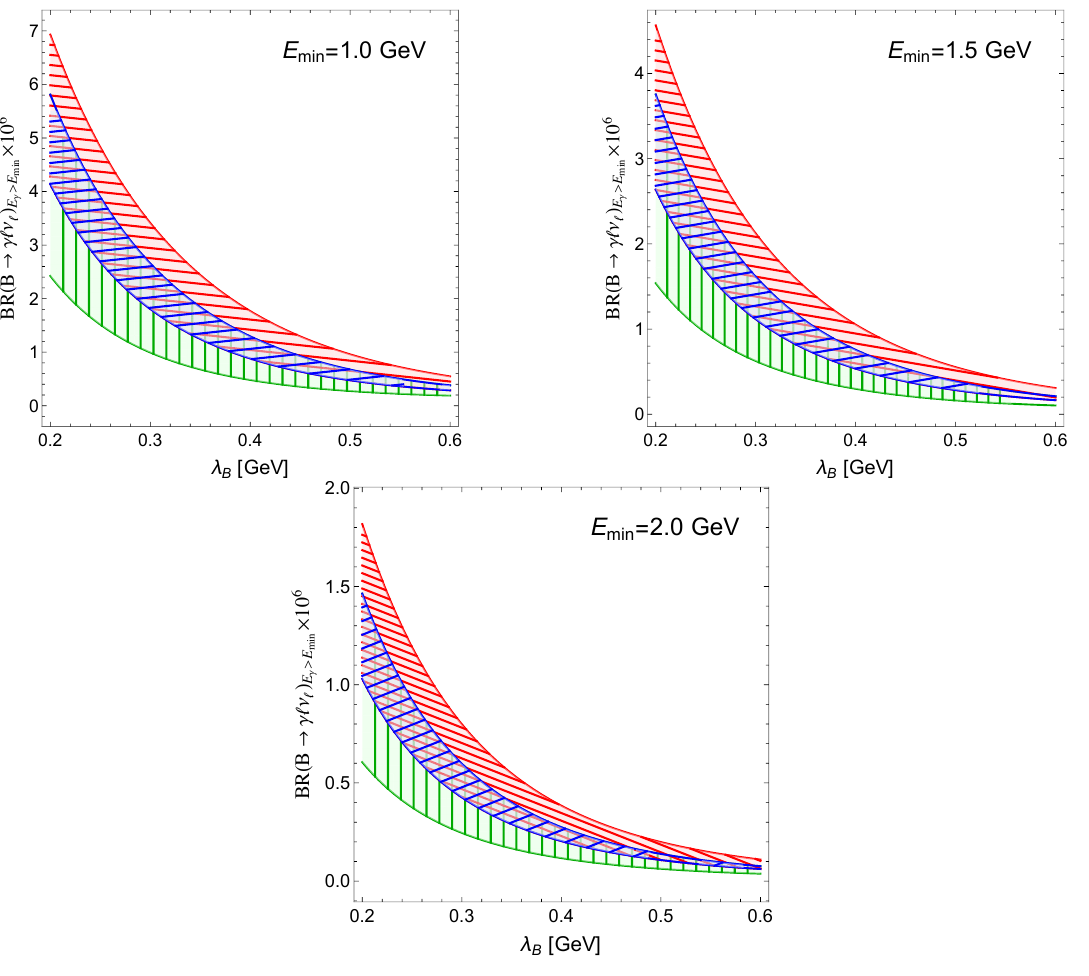
Figure 9 . Integrated partial branching fraction BR( B ! (cid:13)‘(cid:23) ‘ ; E (cid:13) > E min ) for E min = 1 GeV (left), E min = 1 : 5 GeV (right) and E min = 2 GeV